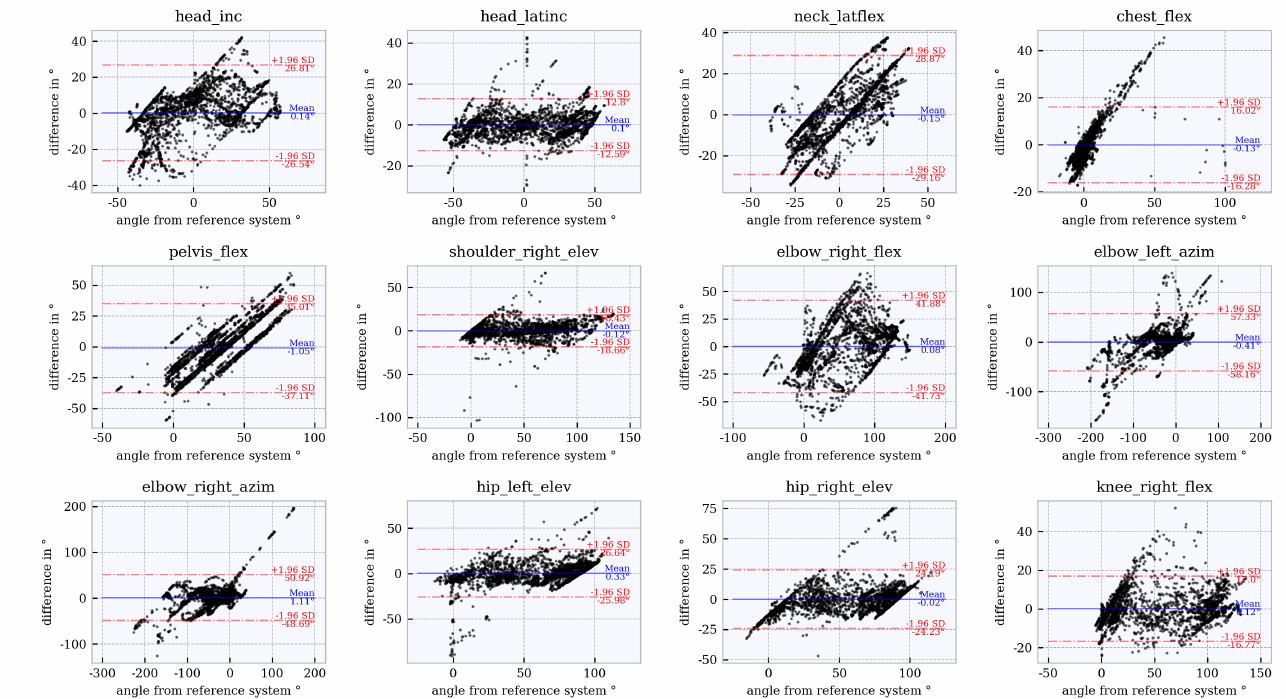
Figure A4. Bland–Altman plot for tracker configuration 8 ; x does not show the average of both systems but the joint angles of the reference system, Qualisys.